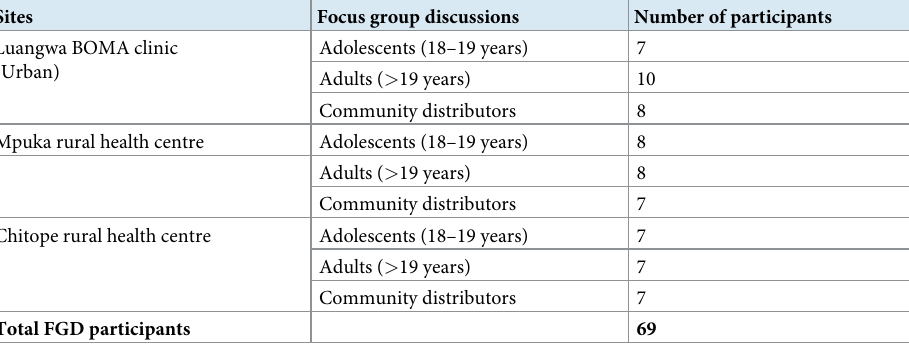
Table 3. Focus group